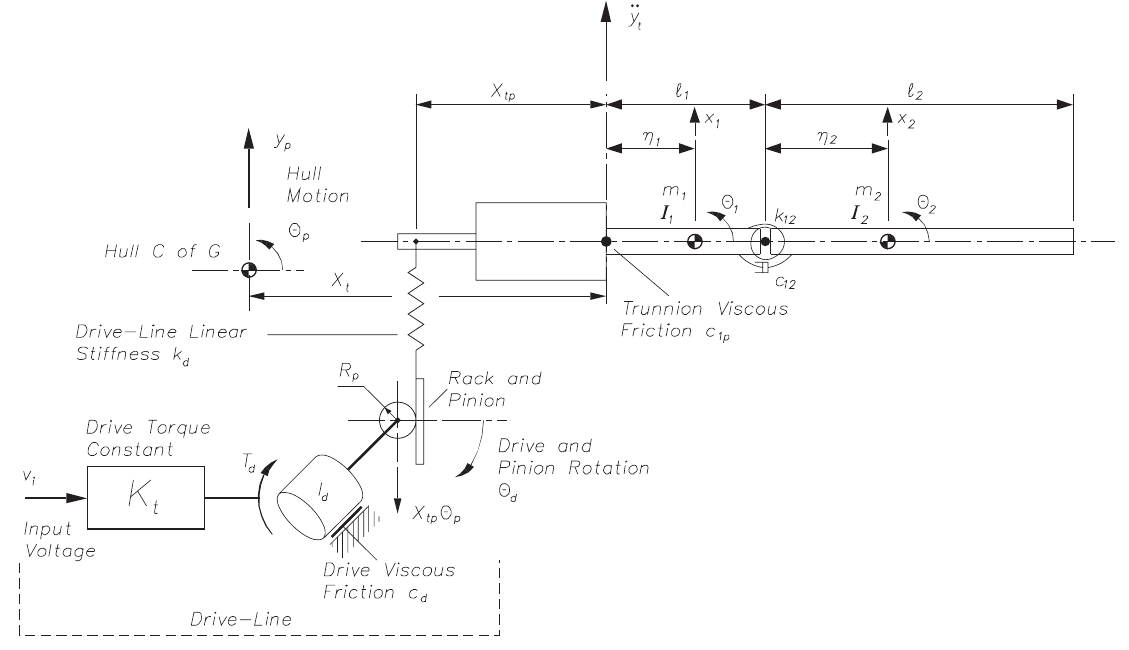
Fig. 1. Elevation model with two section